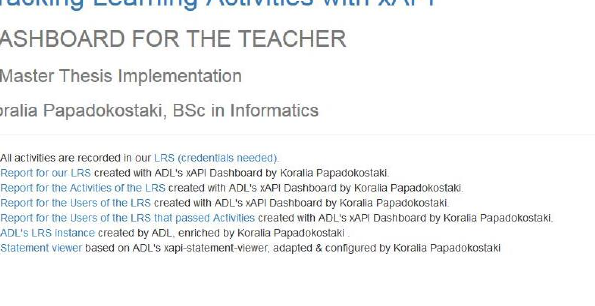
Figure 8. The Teacher’s Dashboard